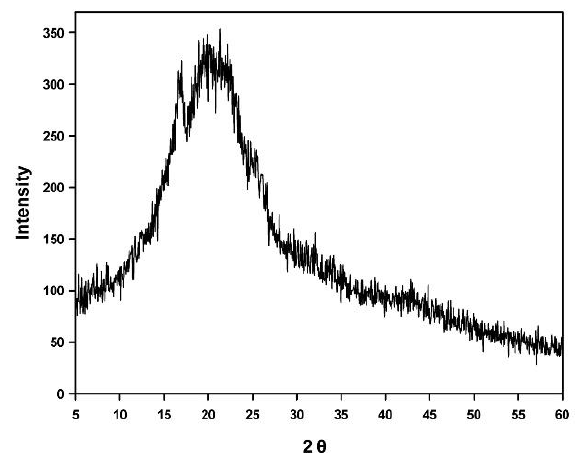
Figure 5. Crystallinity of a film measured using a powder X-ray diffractometer. Partial crystallinity appears from 15° to 20°, but the structure is amorphous overall.